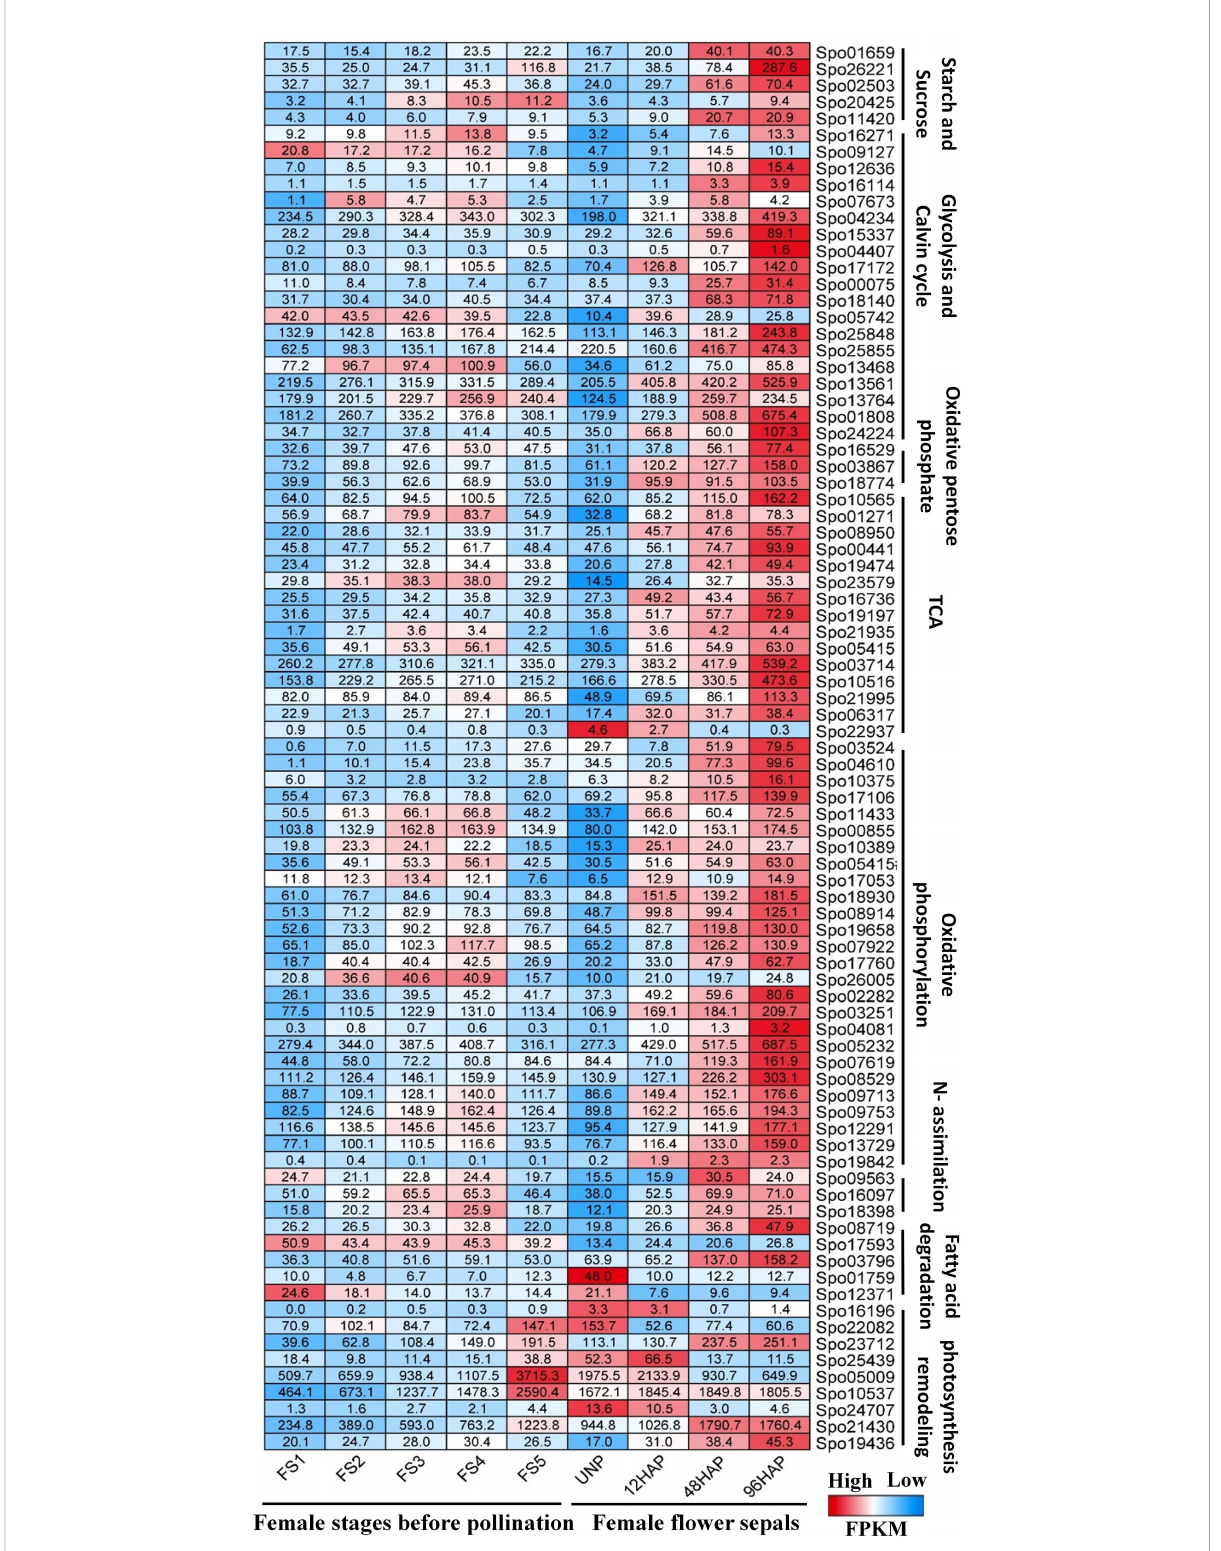
FIGURE 6 Comparative expression pro fi le offemale fl ower at fi ve developmental stages (S1-S5) before pollination and female fl ower ’ s sepal at un-pollinated (UNP) and different time points after pollination (12, 48, 96HAP). Heat-map presented the FPKM values in row scale for respective genes in different